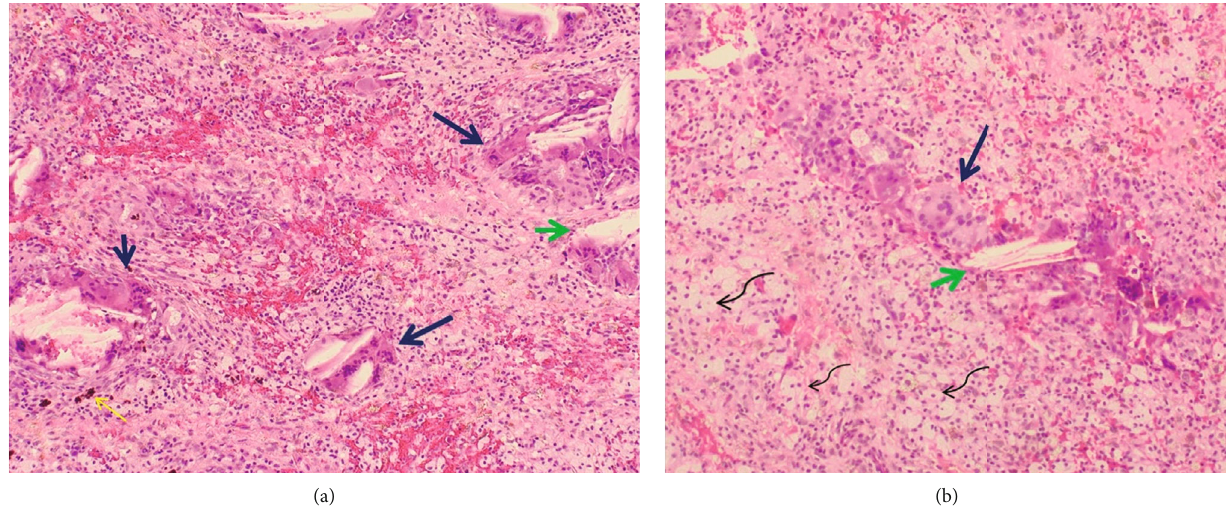
Figure 4: (a, b) Histopathology (hematoxylin and eosin stain (40x) showing multinucleated foreign body giant cells (cholesterol crystals) with xanthomized cells, presence of hemosiderin deposition, and lymphocytic in fl ammatory in fi ltrate. Multinucleated giant cells (thick blue arrows), cholesterol crystals (short green arrows), xanthomized cells (wavy black arrows), and hemosiderin deposits ( fi ne yellow arrow). Table 1: Giant cell reparative granuloma cases involving the